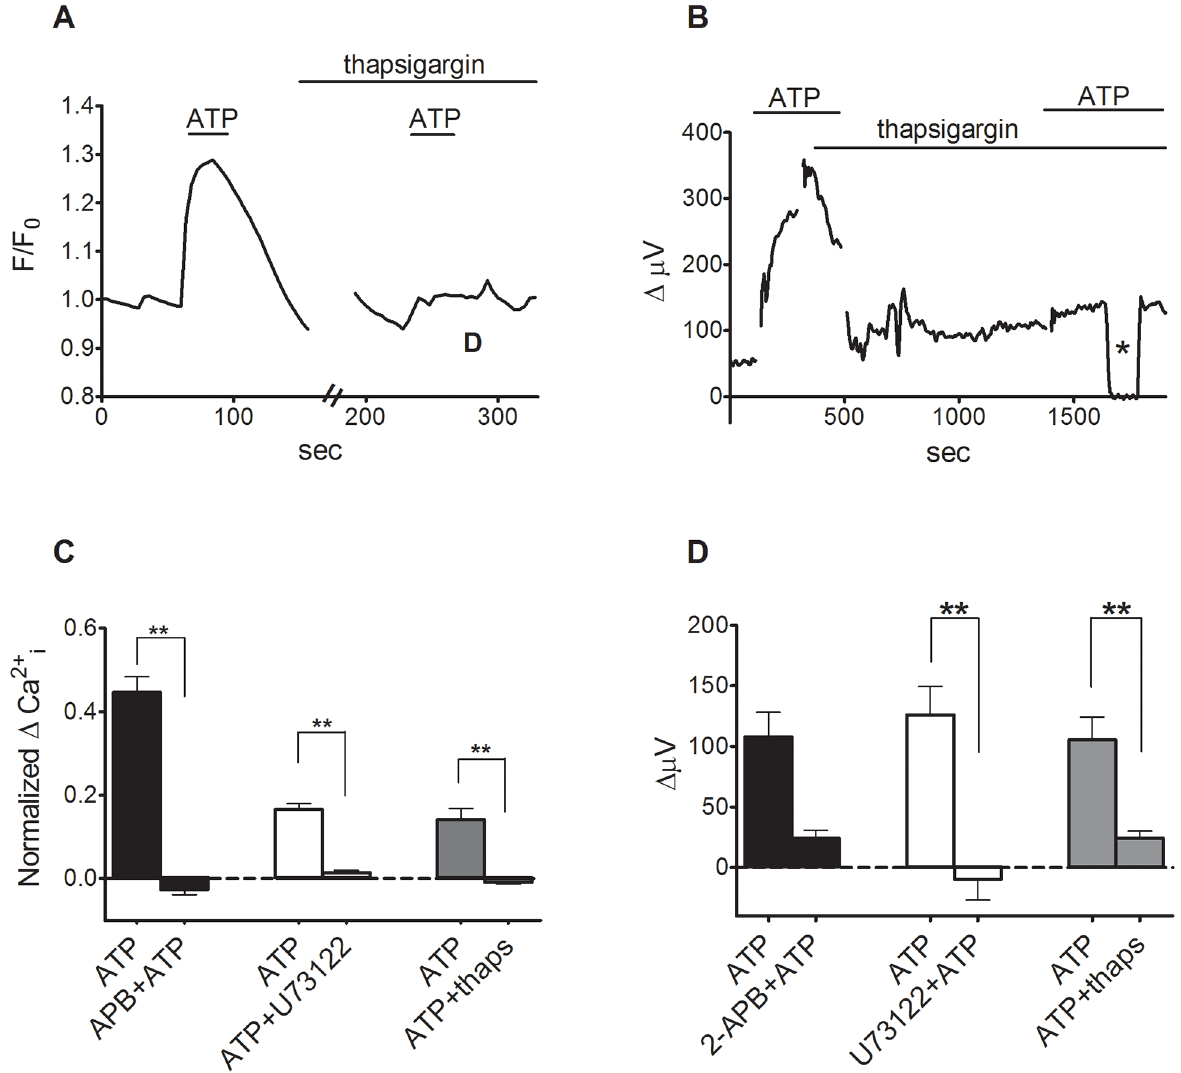
Fig 3. ATP-induced changes in intracellular calcium and extracellular H+ flux. (A) 1 μ M ATP increased intracellular calcium as reported by changes in the fluorescence of the calcium indicator Oregon Green. Subsequent ATP-induced alterations in Oregon Green fluorescence were blocked by 1 μ M thapsigargin applied for 15 minutes. (B) A representative single self-referencing recording from an isolated Mu¨ller cell demonstrating that thapsigargin also reduced the increase in H+ flux induced by 1 μM ATP from Mu¨ller cells; asterisk: background control. (C) Mean responses from imaging data for ATP induced responses in 2-APB, U73122 and thapsigargin. Data was normalized to the last fluorescence data point before treatment. (D) Mean responses with self-referencing. ATP readings represent absolute recorded values minus values of the standing